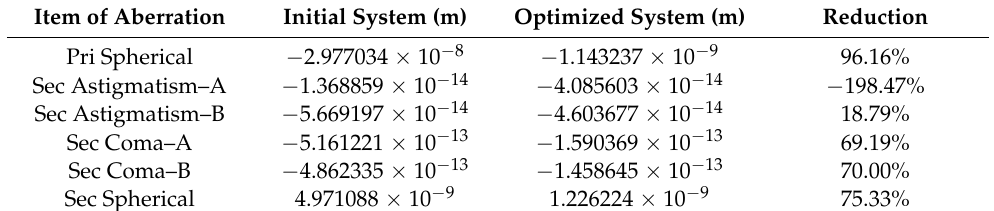
Table 4. Cont. Table 3. Performance comparison between the optimized and initial structure of the secondary mir- ror in the vertical optical axis.